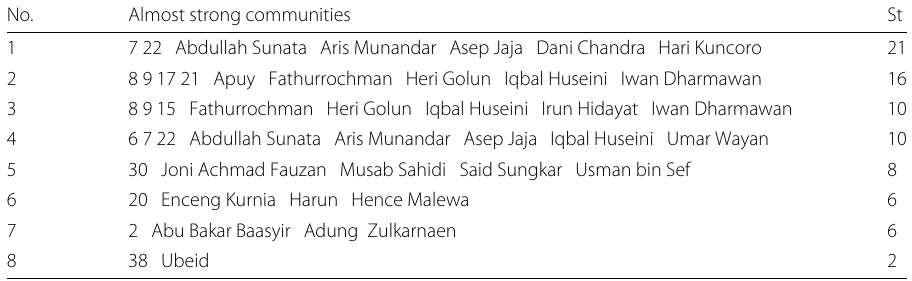
Table 4 The 8 almost strong communities identified using MaxBic in Noordin Top terrorist network No. Almost strong communities St